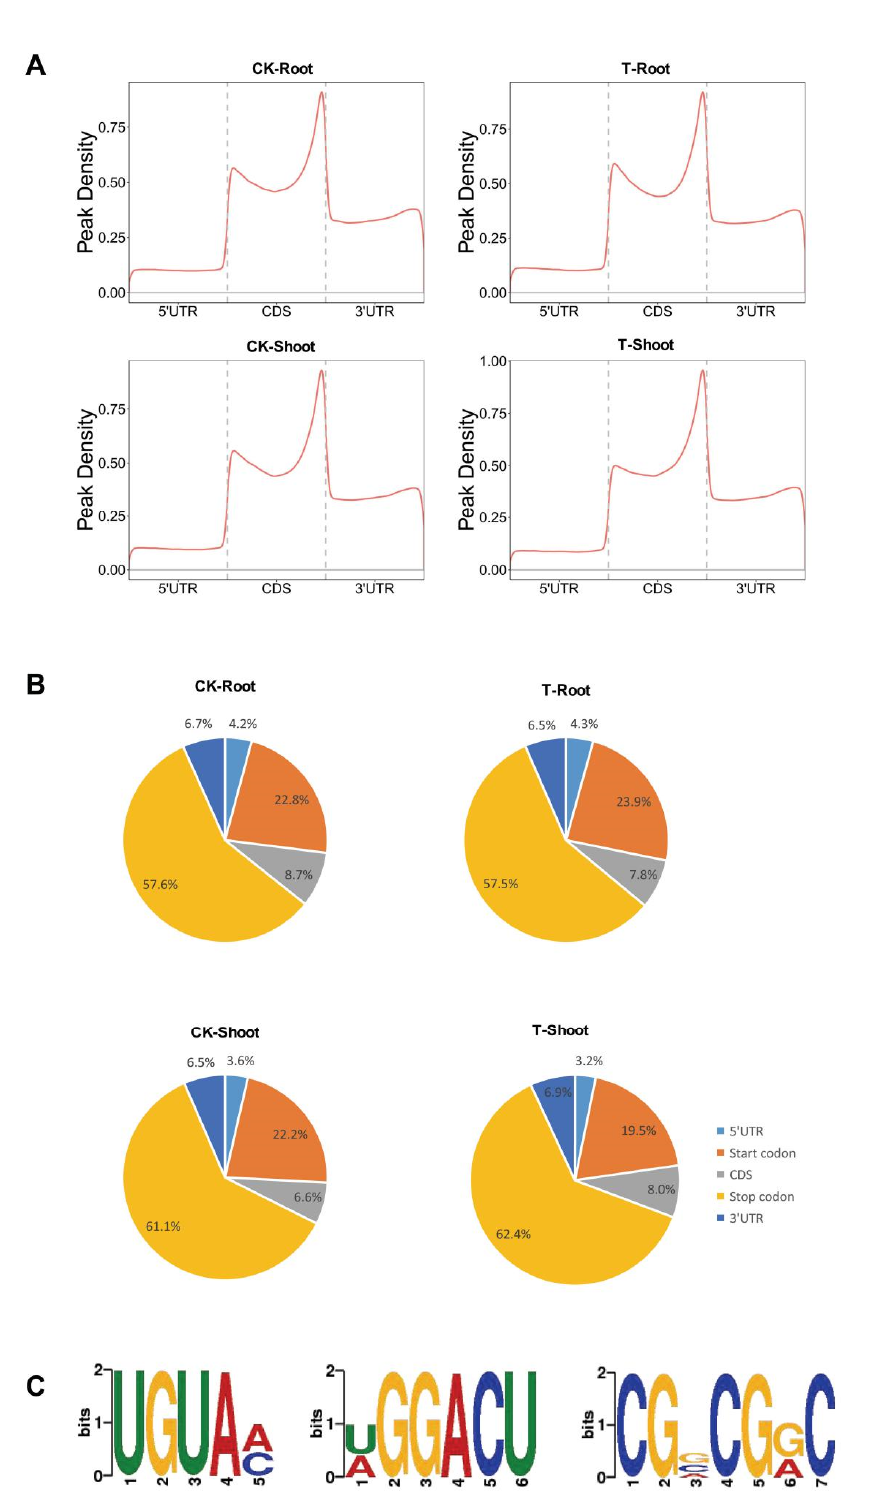
Figure 4. Characteristics of m 6 A localization and sequence motifs in rice shoots and roots under salt stress (T) and control (CK) conditions. ( A ) Metagenomic profiles of peak distributions along the transcripts comprising three rescaled non-overlapping segments [5 (cid:48) untranslated region (UTR), coding sequence (CDS), and 3 (cid:48) UTR]; ( B ) Proportions of m 6 A peaks in five non-overlapping tran- script segments: transcription initiation site (TSS), 5 (cid:48) UTR, CDS, termination codon, and 3 (cid:48) UTR; ( C ) Sequence motifs identified within m 6 A peaks using the DREME